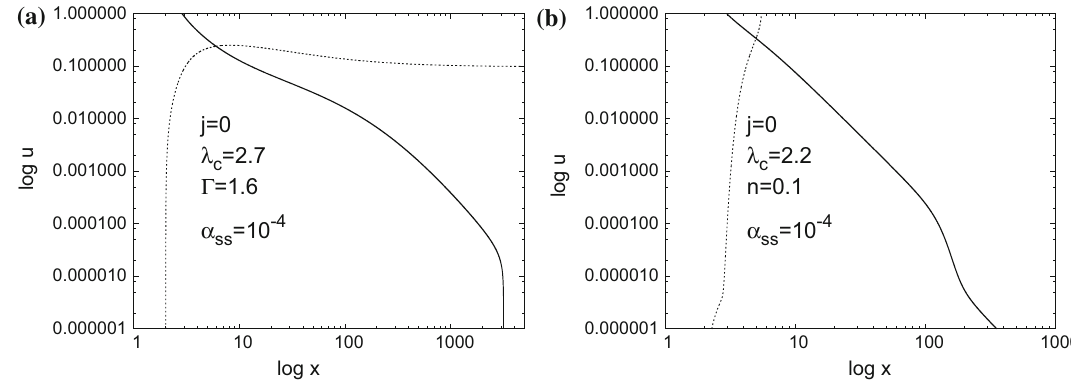
Fig. 1 a , b are plots of log ( u ) vs. log ( x ) for non-viscous accretion disc flow around a non-rotating BH for adiabatic and MCG, respectively. Accretion and wind curves are depicted by solid and dotted lines, respectively